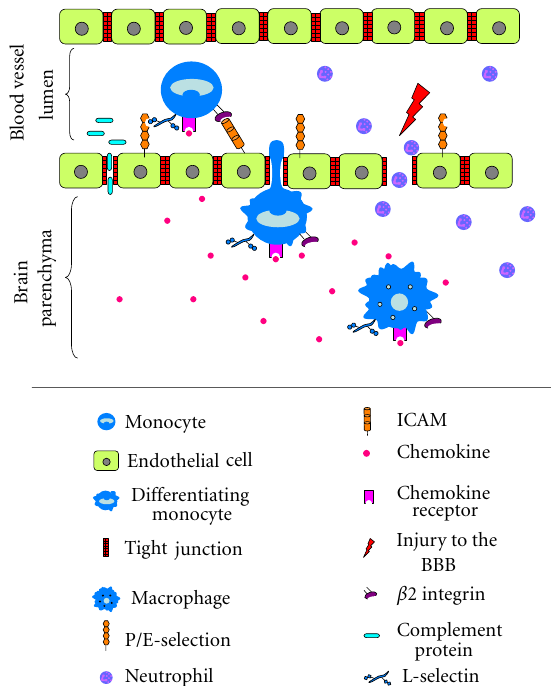
Figure 1: Passage of innate immune components through the blood brain barrier (BBB) after TBI. Injury to the brain results in transient opening of the BBB, in which complement proteins and neutrophils are able to directly enter the parenchyma. Peripheral monocytes enter the brain through a process of extravasation, in which several adhesion molecules are upregulated in turn on both the monocyte and endothelial cell to first tether, then provide passage for the cell through the BBB. First, constitutively expressed L-selectin binds to upregulated P/E- selectin on the endothelial cell surface. Once tethered to the endothelium, monocytes are exposed to chemokines that bind to their cognate receptors on the cell, inducing conformational change and upregulation of β 2 integrins, which bind to ICAMs expressed on endothelial cells. This final interaction between adhesion molecules signals the cell to migrate across the endothelium into the parenchyma, where it begins to di ff erentiate and take on the morphology of an activated macrophage. Under the influence of chemokines, the cell continues the transition to an activated macrophage state migrates to the site of injury. Figure adapted from